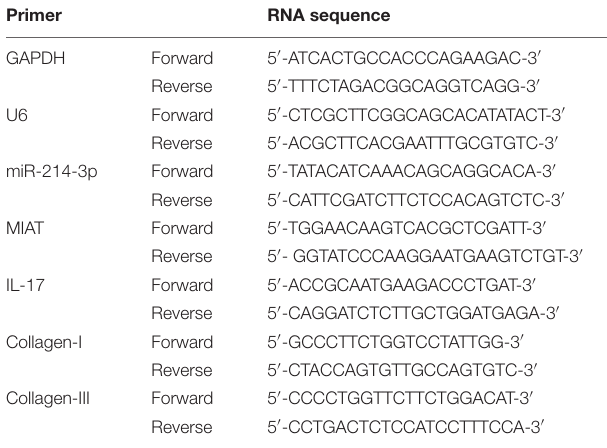
TABLE 2 | PCR primer sequence. Primer RNA